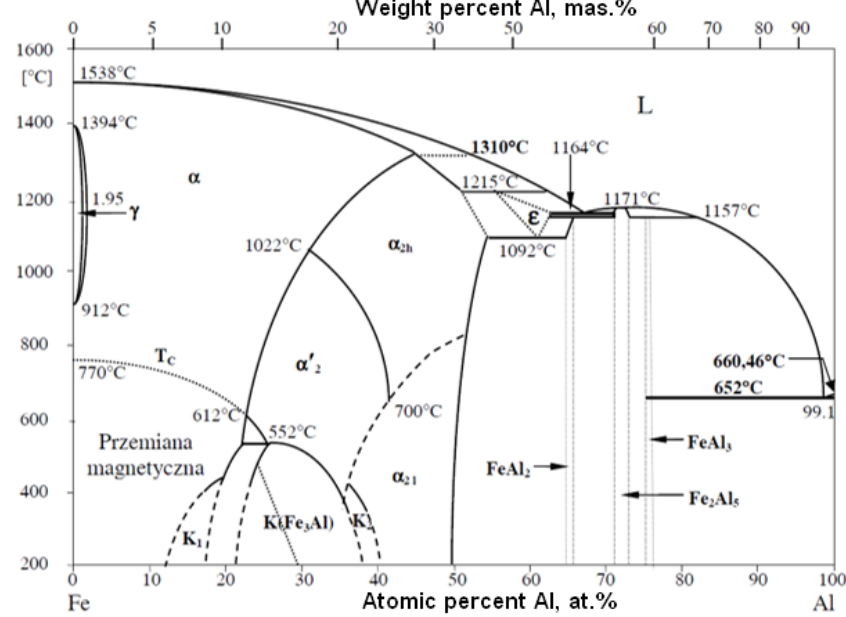
Figure 4. FeAl equilibrium system.